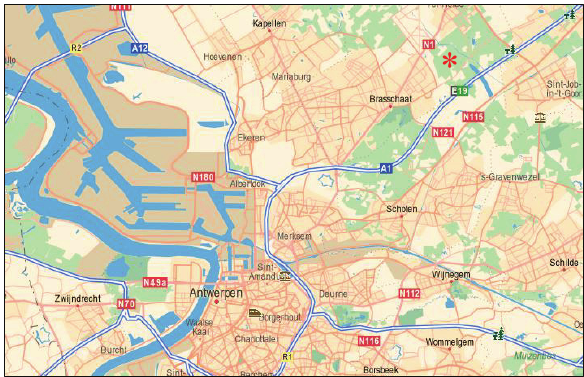
Fig. 1. Map of Antwerp, Belgium, and surroundings with the loca- Figure 1. Map of Antwerp, Belgium, and surroundings with the location of the Brasschaat sampling site indicated with a red asterisk. tion of the Brasschaat sampling site indicated with a red